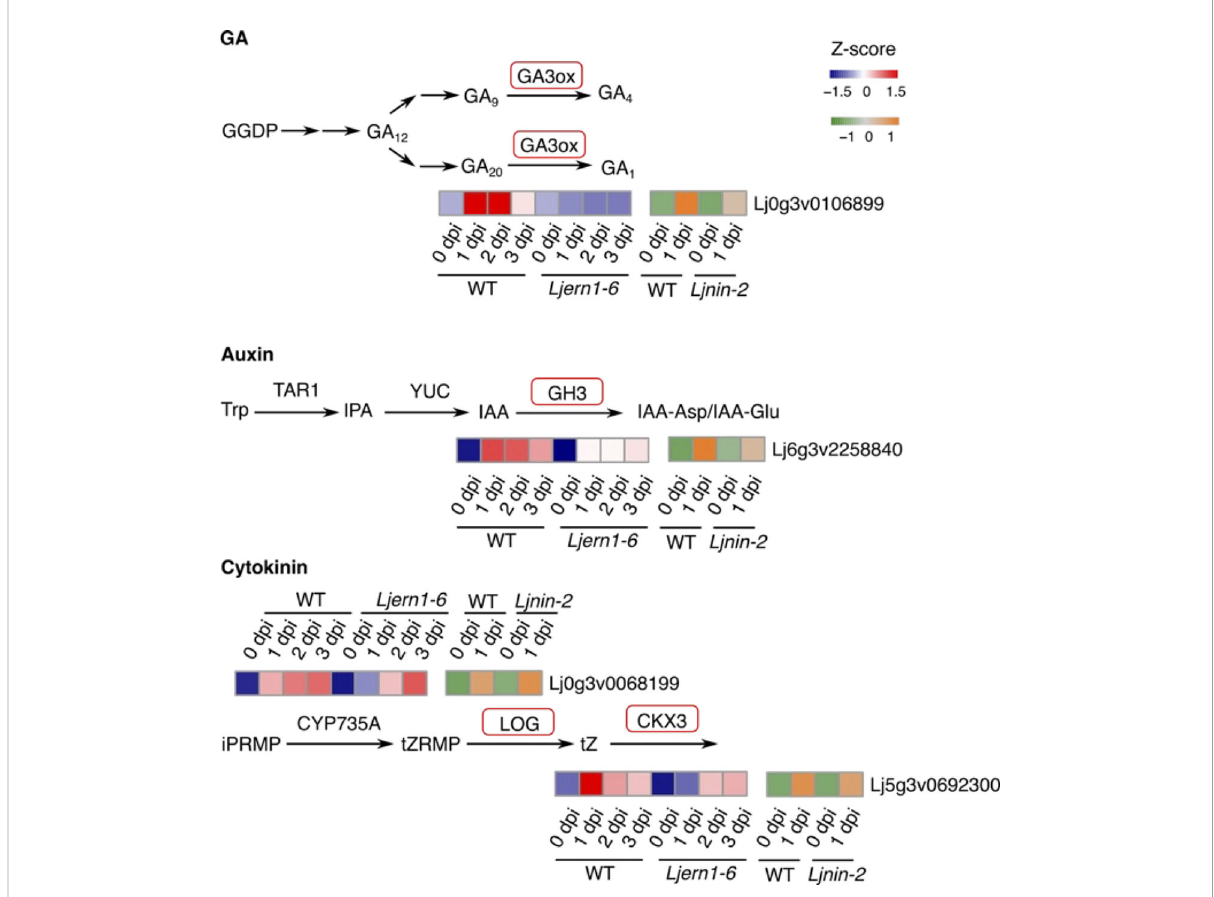
FIGURE 5 Phytohormone-associated DEGs in WT and mutants. Simpli fi ed GA, auxin, and cytokinin biosynthesis pathways were shown. Genes encoding enzymes with red frames were signi fi cantly reduced in Ljern1-6 mutants. Heatmaps show the expression patterns of corresponding genes in WT and